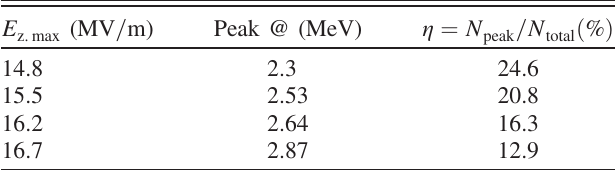
TABLE I. The statistics of the energy spectrum in Fig. 10.